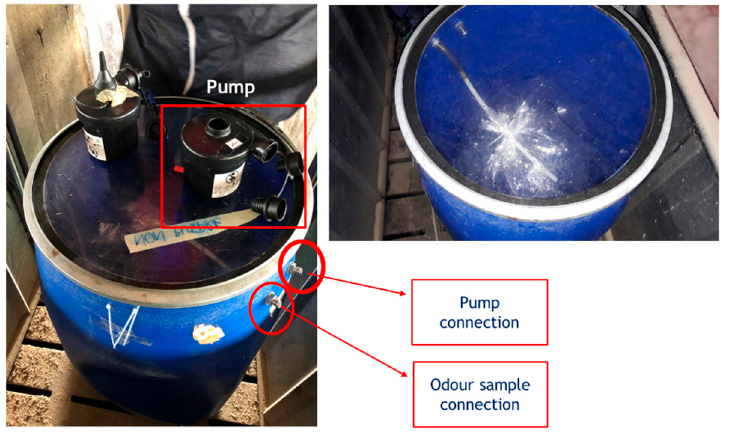
Figure 2. Sampling system.